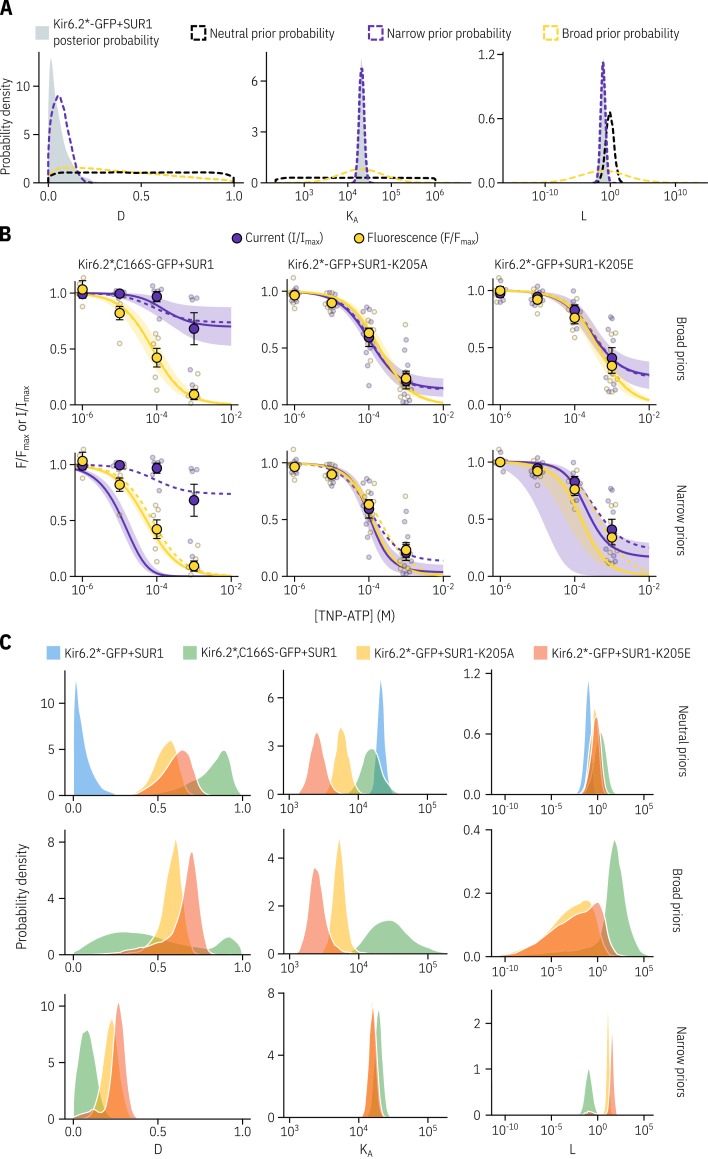
A neutral choice of priors allows for the best fits to the data.(A) We generated more informative priors (dashed lines) based on our posterior probability distributions for Kir6.2*-GFP + SUR1 (in grey) by fitting the posterior distribution for each parameter with a normal distribution. In addition to this narrow informative prior, we generated a broad informative prior still centered on the Kir6.2*-GFP + SUR1 posterior probability density by increasing the standard deviation of the fitted normal distribution by a factor of ten. (B) Fits to the PCF data for all constructs tested using either the neutral priors reported earlier (shown as dashed lines), or priors based on the fits to Kir6.2*-GFP + SUR with the solid curves representing the median fit and the shaded area representing the 95% quantiles. (C) The posterior probability distributions corresponding to the fits shown in B are shown for each parameter.